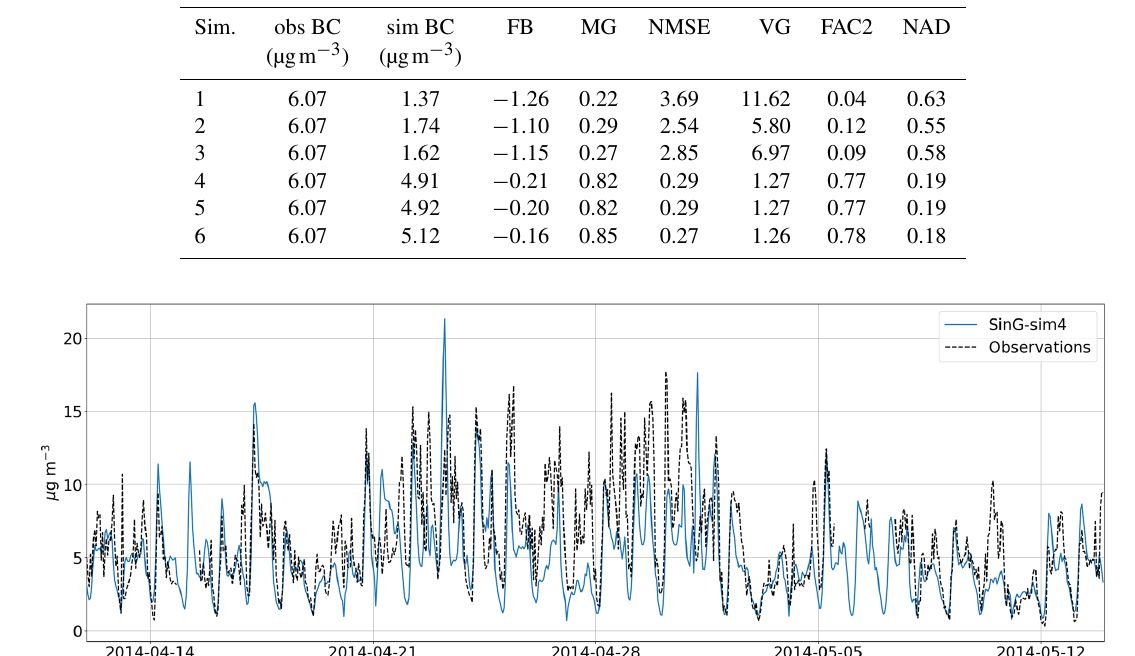
Figure 3. BC hourly concentrations in Boulevard Alsace Lorraine simulated by SinG (simulation 4) and observed during the TRAFIPOLLU campaign (µgm − 3 ).